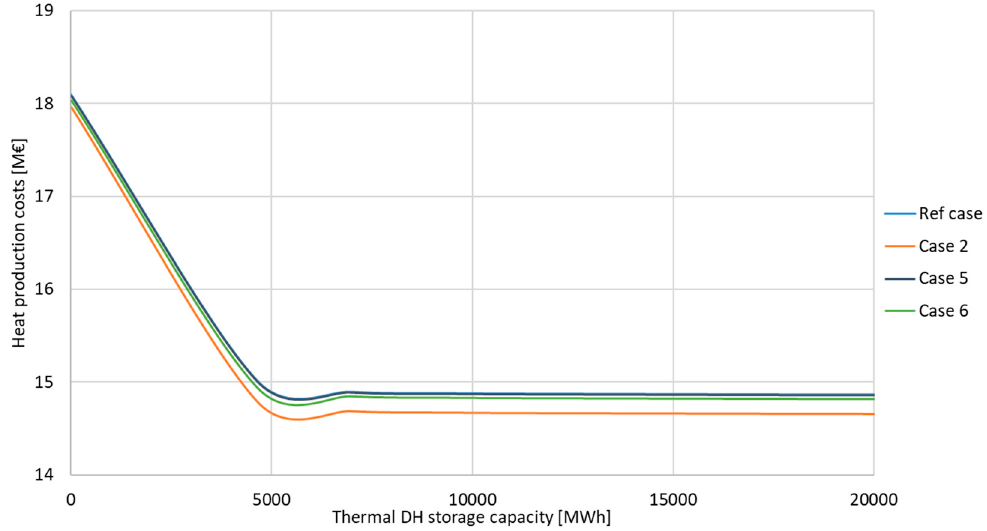
Figure 8. Heat production costs as a function of the heat storage capacity. Table 5. Key operation results of the DH system in di ff erent DR cases with and without HWT in the